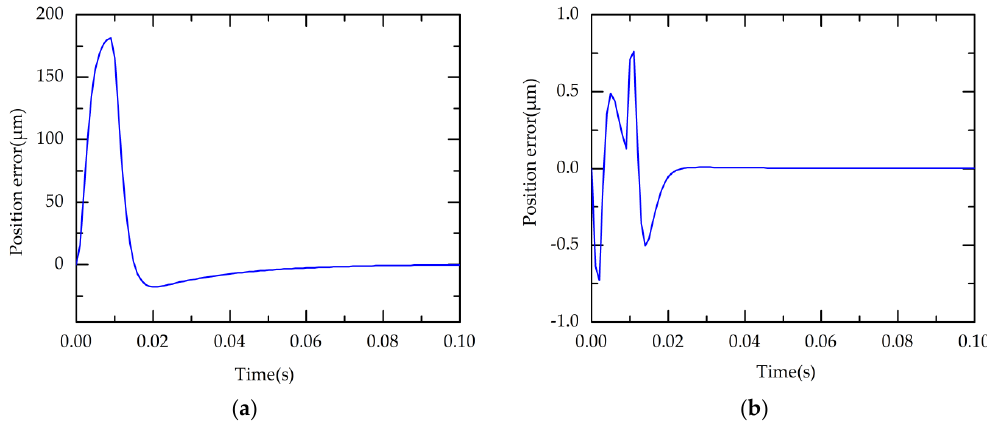
Figure 9. Position error of the proposed controller: ( a ) with the reduced-order ESO; and ( b ) with the model-assisted reduced-order ESO.